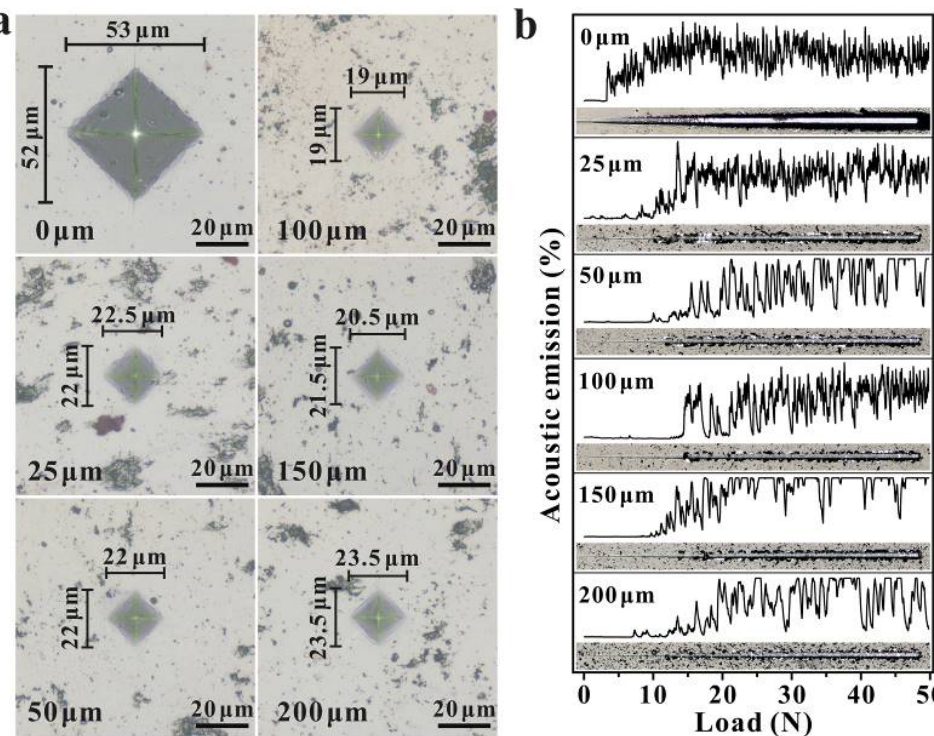
Figure 7. Optical morphology of ( a ) Vickers indentation and ( b ) scratches of the PVD coating and HVOF-PVD duplex coatings. Reprinted with permission from Ref. [57]. Copyright Elsevier, 2022.